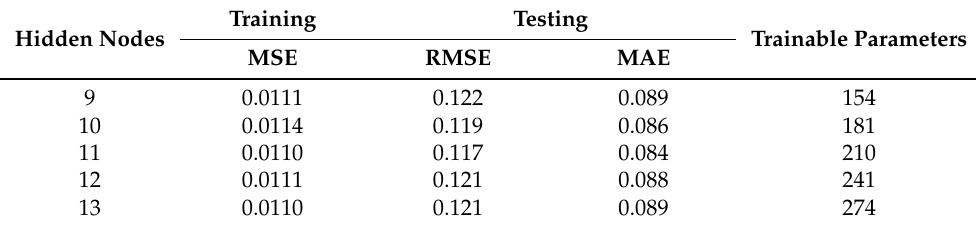
Table 8. Impact of hidden neurons on the performance of the model “RHM-2”. Training Hidden Nodes